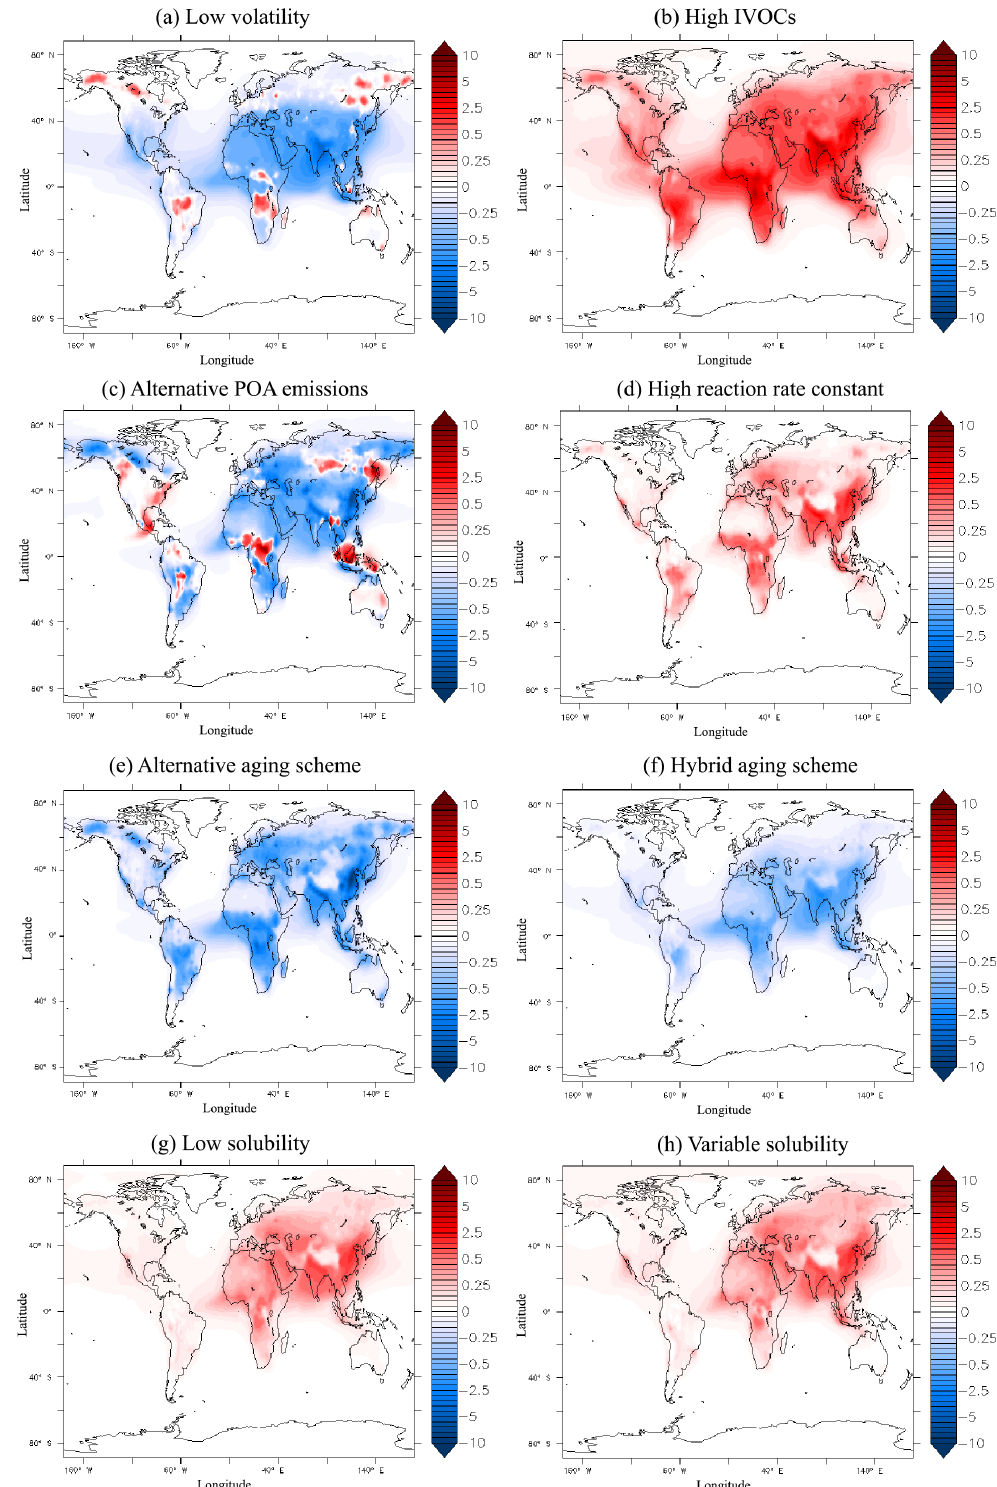
Figure 7. Absolute changes (inµgm − 3 ) of the average surface total OA concentrations between the reference and the (a) low-volatility, (b) high IVOCs, (c) alternative POA emissions, (d) high reaction rate constant, (e) alternative aging scheme, (f) hybrid aging scheme, (g) low-solubility, and (h) variable solubility simulations during the period 2001–2010. A positive change indicates an increase in the sensitivity